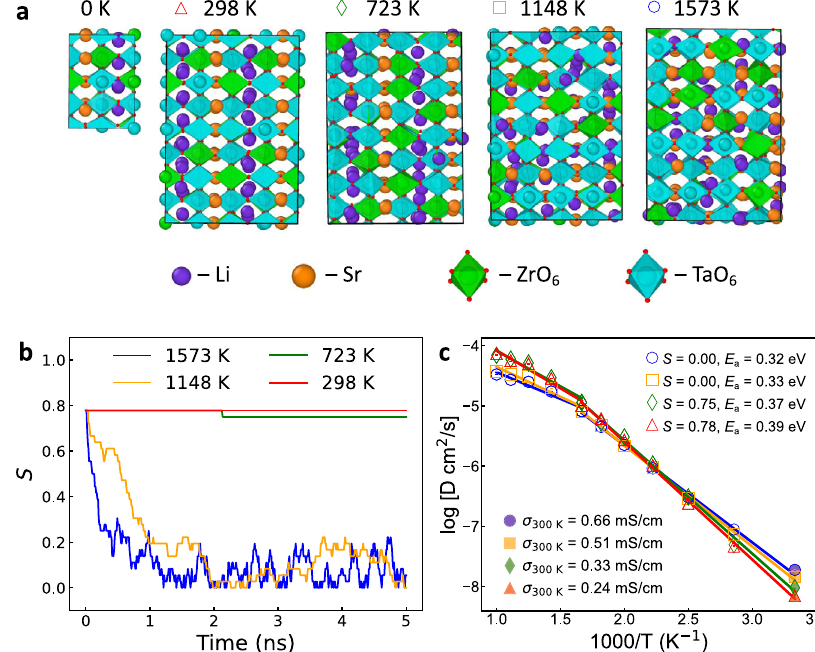
Fig. 2 | The temperature-dependent A-site ordering in bulk LSTZ0.75 and its occupancybySrinSr-richlayersandtheoverallA-siteoccupancybySrinLSTZ.For effectonLi + diffusion.a CrystalstructureofLSTZ0.75unitcellwiththemoststable LSTZ0.75, S rangesfrom0(completedisorder)to0.78(allSrinSr-richlayers). c The Arrheniusplotofthefourmodelsequilibratedatdifferenttemperatures.Theroom orderingbyDFTat0Kandthe2×2×2supercellsequilibratedbyMC/MDwithMTP temperature ionic conductivity ( σ 300K ), S and activation energy ( E a ) below 600K at298to1573Kwith425Kintervals. b TheevolutionofA-siteorderingparameter S during the 5ns MC/MD simulations at the four temperatures. The A-site ordering were , where R Sr (cid:2) rich and R Sr (cid:2) overall refer to A-site parameter is given by S = R Sr (cid:2) rich (cid:2) R Sr (cid:2) overall 1 (cid:2) R Sr (cid:2) overall